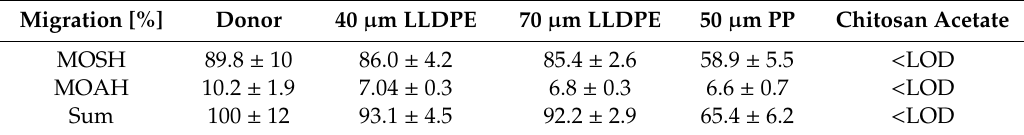
Table 2. Barrier properties of polymer films against the migration of MOSH and MOAH from a recycled paper donor; given in % of donor. n = 3.